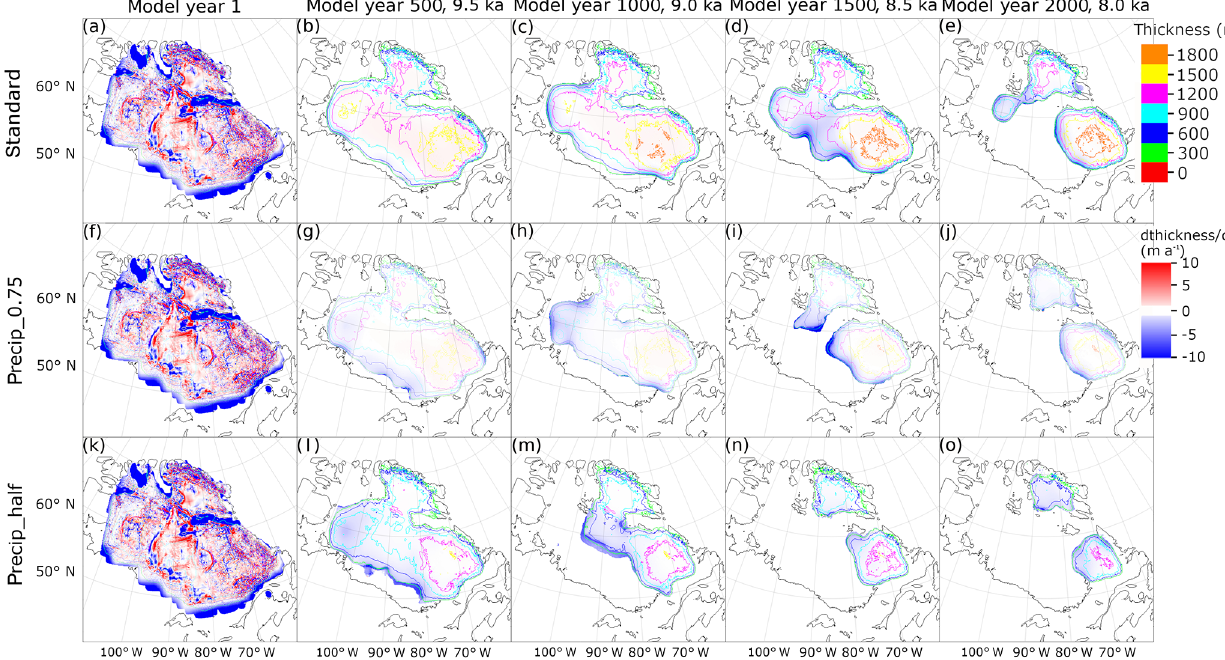
Figure 10. Laurentide Ice Sheet thickness evolution in the three simulations with varying precipitation fields in 500-year intervals. (a) – (e) standard, (f) – (j) precip_0.75 ( P field in standard multiplied by 0.75) and (k) – (o) precip_half ( P field in standard